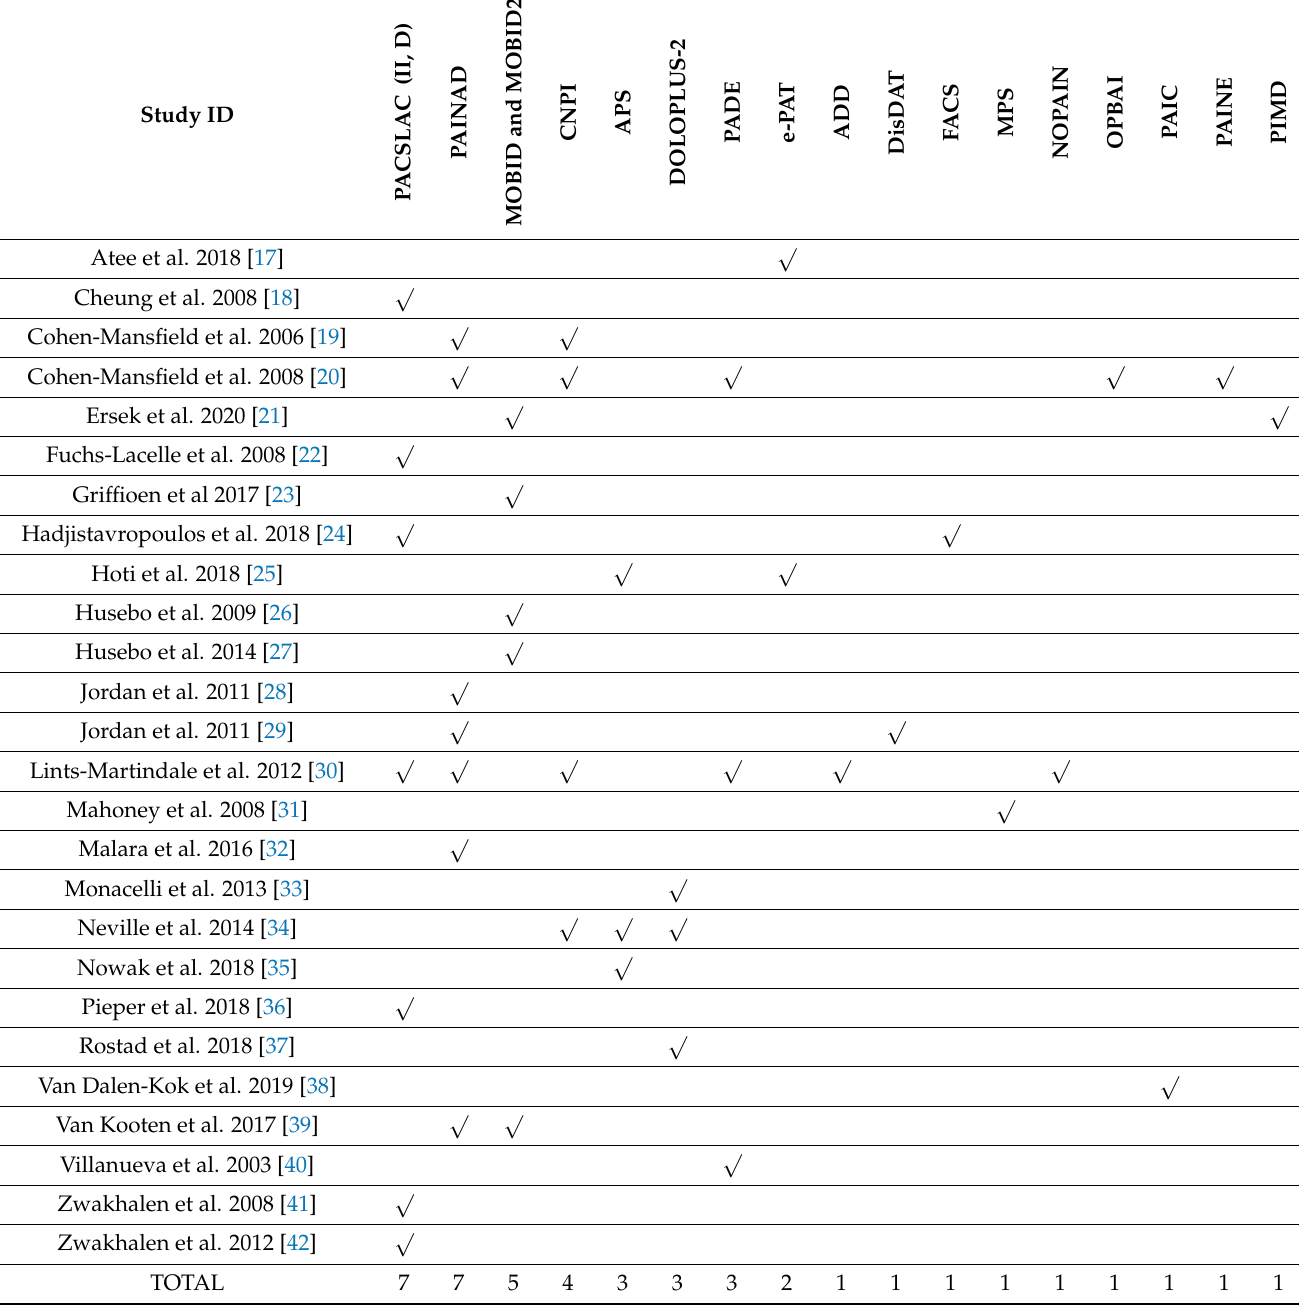
Table 2. Frequency of pain assessment